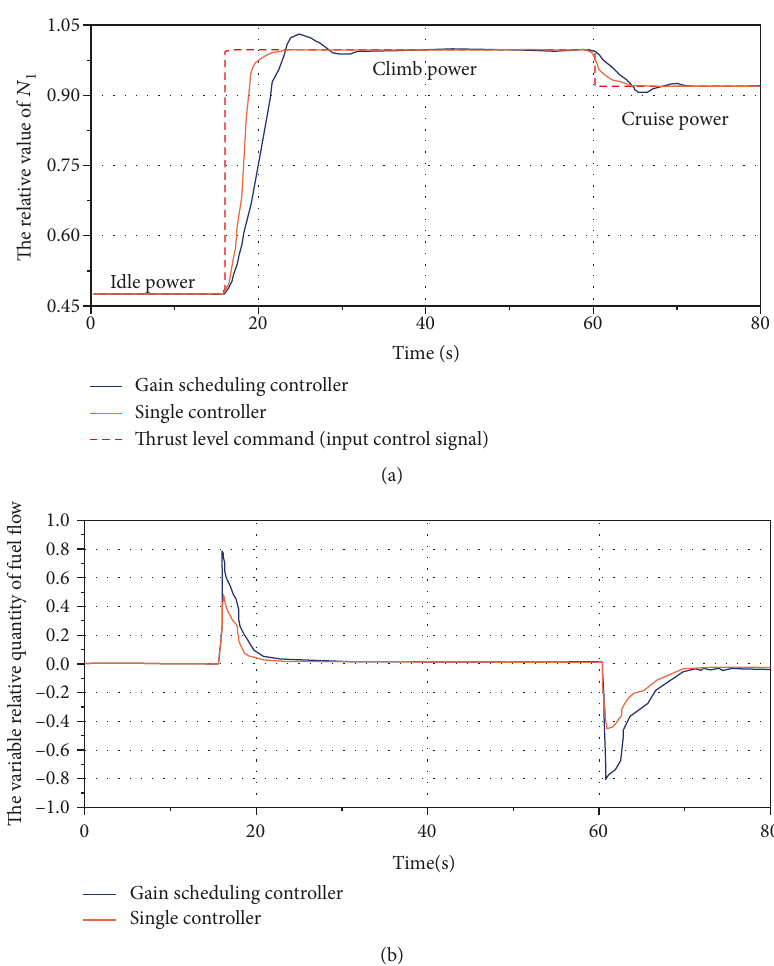
Figure 9: The simulation results of transition state power management. (a) Low pressure rotor speed N quantity of fuel fl ow versus time